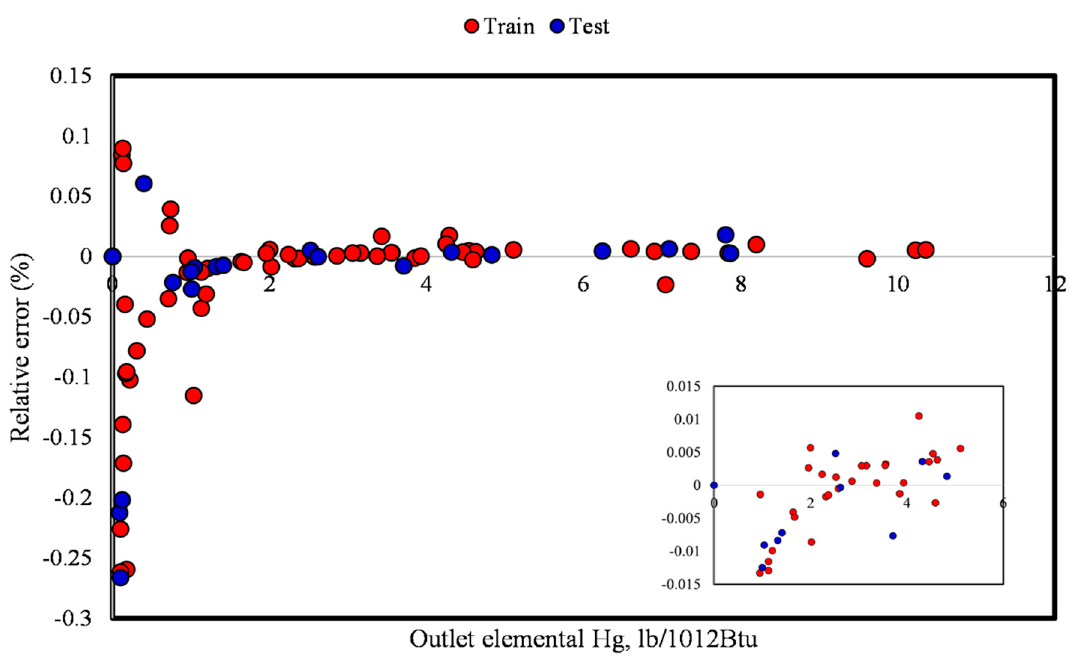
Figure 6. Regressions derived between the estimated and collected data on mercury emissions.